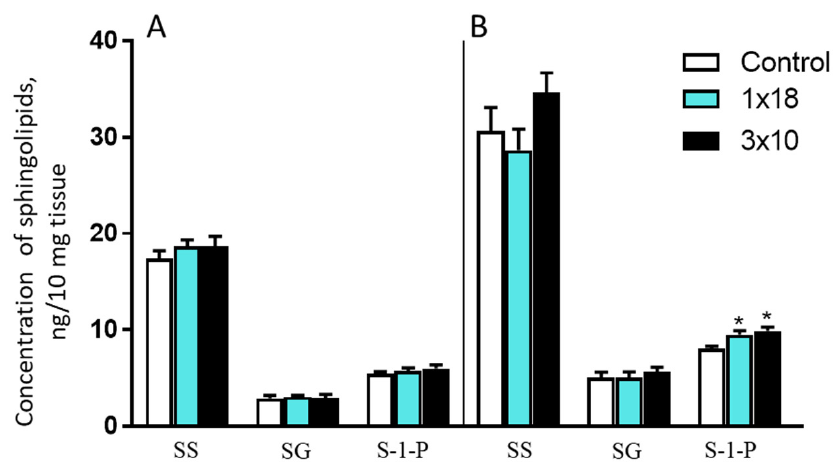
Figure 6. Concentration of sphingosine (SS), sphinganine (SG), and sphingosine-1-phosphate (S-1-P) in the striatum ( A ) and in the substantia nigra ( B ) in mice 2 weeks after the administration of 1-methyl-4-phenyl-1,2,3,6-tetrahydropyridine, once at a single dose of 18 mg/kg or three times at a single dose of 10 mg/kg. * p < 0.05, significant differences compared to the controls.